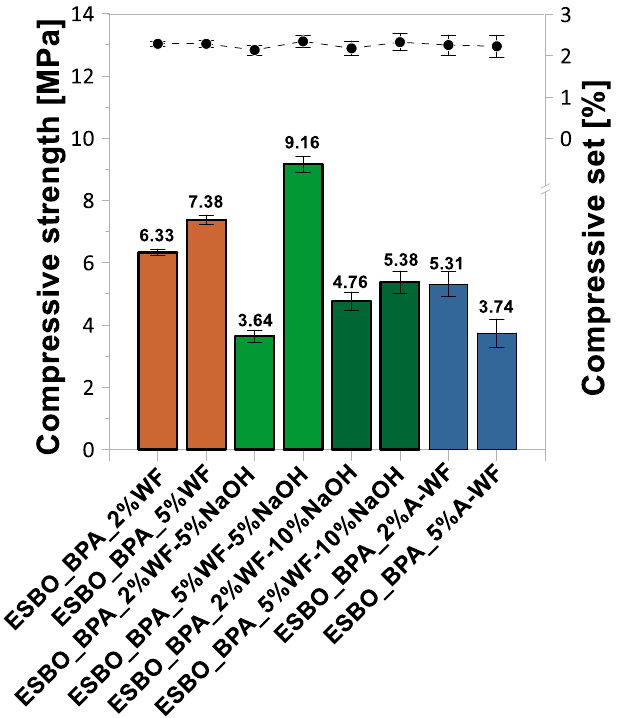
Figure 7. Compressive strength and compression set of compositions based on ESBO_BPA filled with waste oak flour. Table 2. Mechanical properties of compositions based on ESBO_BPA filled with wood flour.